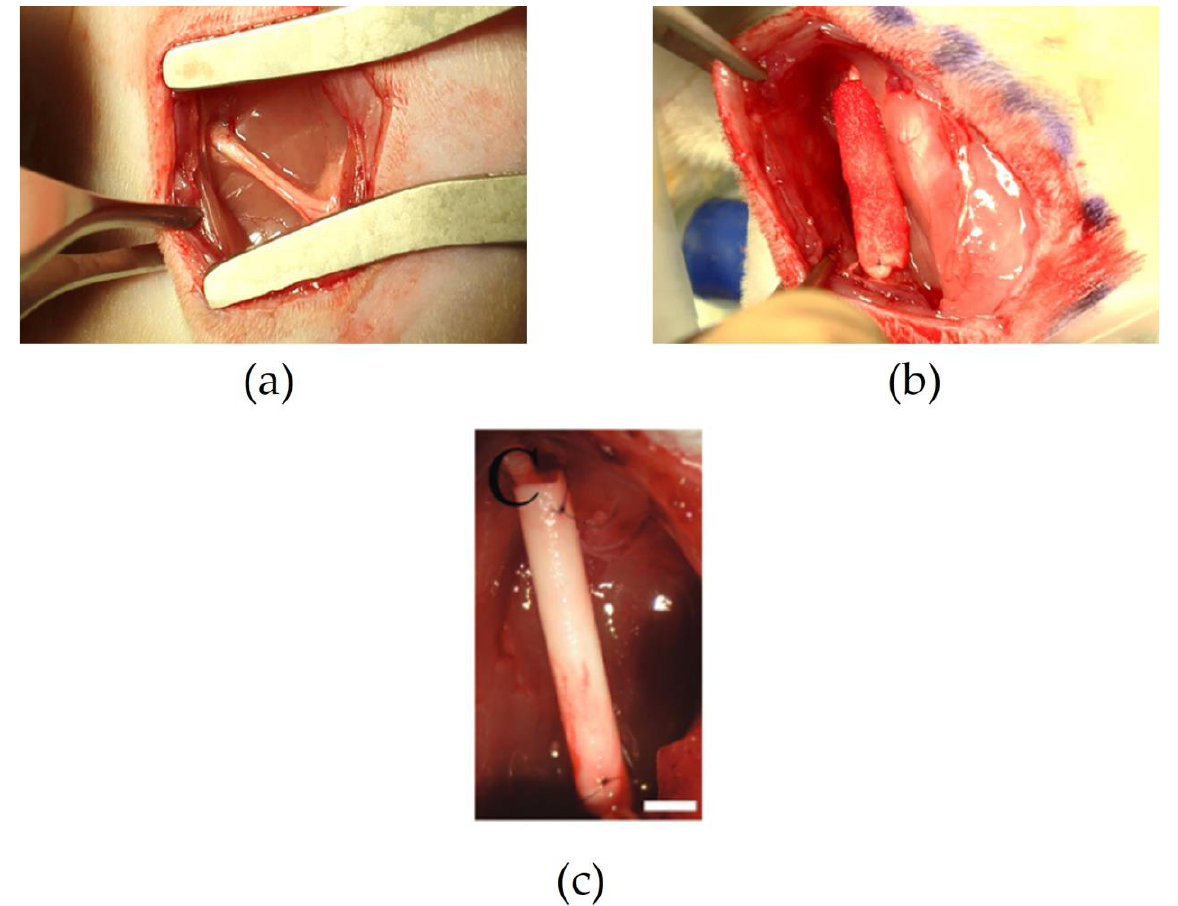
Figure 2. Images of native nerve, implanted NGC, and autograft. ( a ) Native rat sciatic nerve. ( b ) Implanted NGC to regenerate 15 mm sciatic nerve defect.Adapted from/Reproduced with permission from [7]. Copyright Elsevier, 2019. ( c ) Implanted NGC manufactured by electrospinning. Adapted from/Reproduced with permission from [8]. Copyright John Wiley & Sons, 1999.